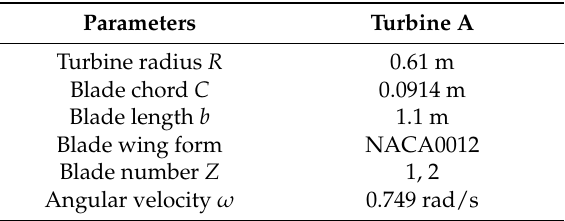
Table 1. Turbine model parameters (Strickland